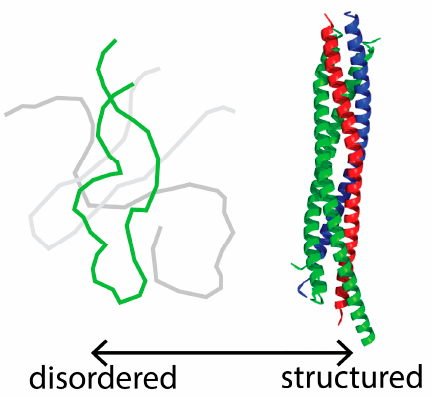
Figure 1. Intrinsically disordered protein (IDP) vs. structured protein. (LEFT) A diagram representing free SNAP-25 (synaptosome-associated protein of 25 kDa, green), which is disordered in isolation. The gray lines represent potential alternative conformations of the protein, consistent with a flexible structure. SNAP-25 folds into a stable structure upon binding its partner SNARE (soluble N -ethyl maleimide sensitive factor attachment receptor) proteins. (RIGHT) The SNARE complex [protein databank (PDB) ID: 1SFC)] with synaptobrevin-II (blue), syntaxin-1A (red), and SNAP-25 (green). Note SNAP-25 becomes stably structured within the SNARE complex.